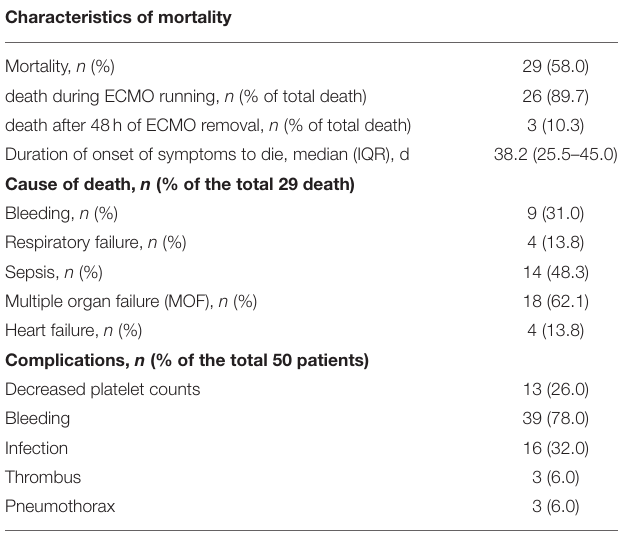
TABLE 4 | Complications of patients treated with extracorporeal membrane oxygenation. Characteristics of